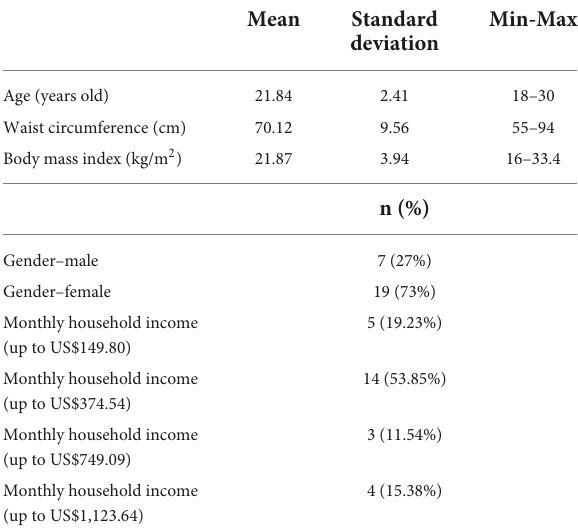
TABLE 1 Final sample